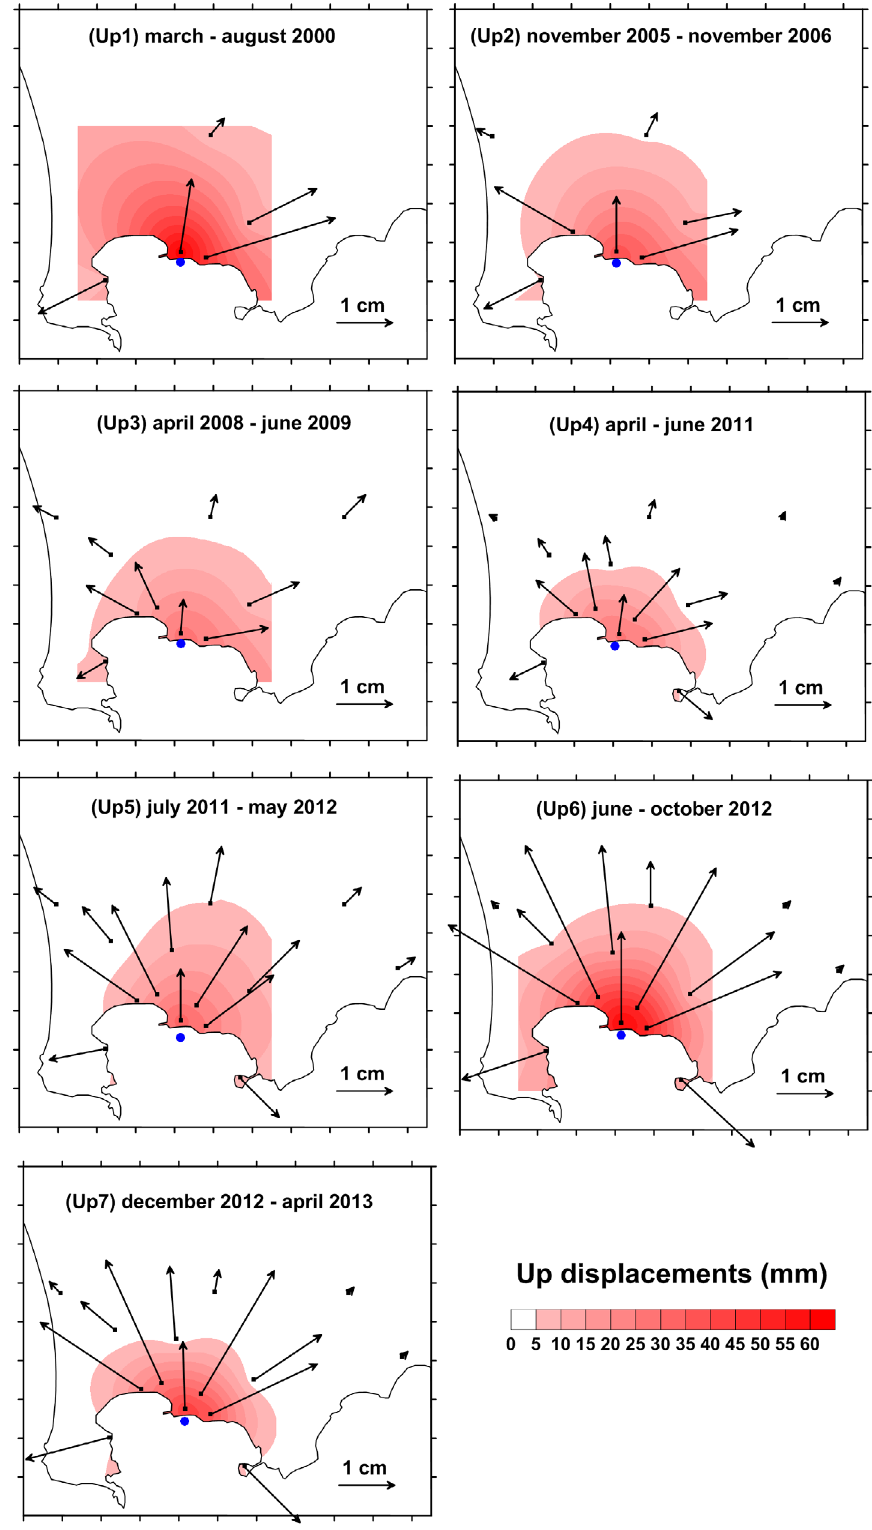
Figure 6. The vectors show the magnitude and direction of displacement of each continuous GPS station during the selected 7 uplift peri- ods in Figure 5. For each period have shown the position of the source obtained by means joint inversion of horizontal and vertical dis- placements, and uplift